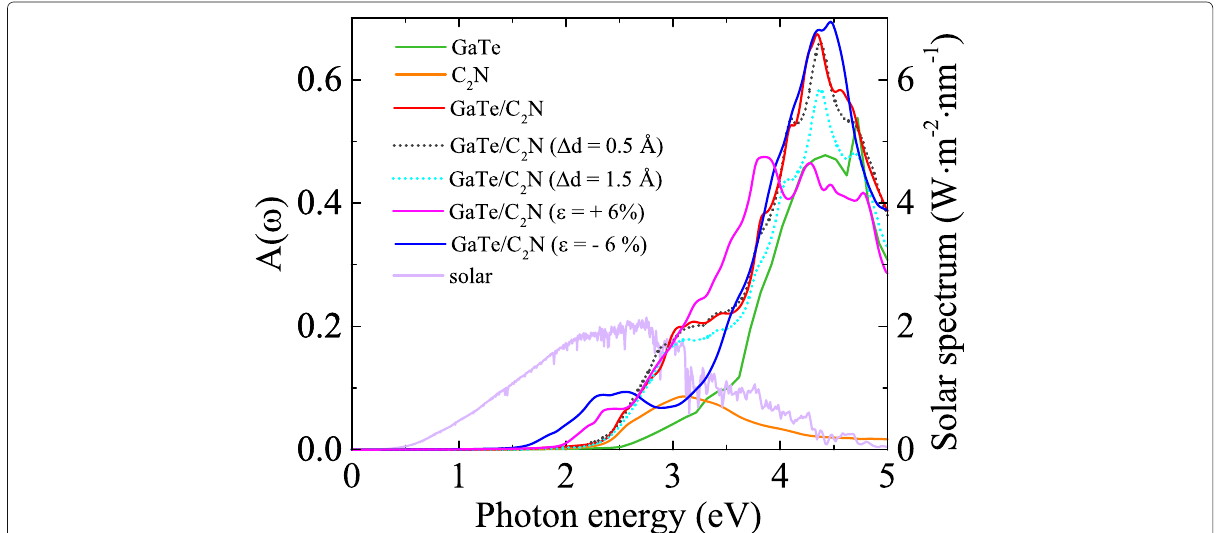
Fig. 3 The calculated optical absorption spectra A (ω) of the GaTe/C 2 N heterostructure and its components using hybrid HSE06 functional. A (ω) of the heterostructures with vertical strains of 0.5 Å and 1.5 Å and in-plane strains of +6% and -6%. And the solar spectrum are also shown for